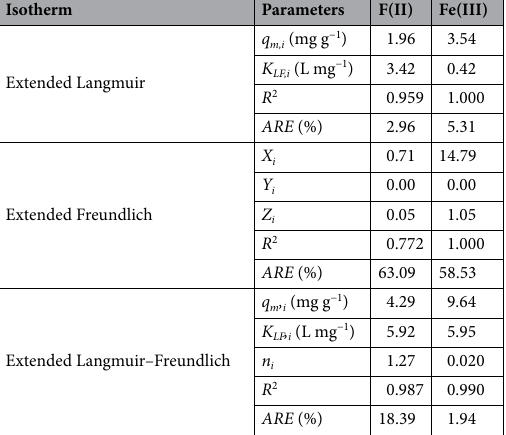
−1 in a single system was 251.3 and d values at initial iron concentration of 15 mg L 309.4 L kg −1 for Fe(II) and Fe(III), respectively. In the binary system the distribution coefficient K d for Fe(II) was